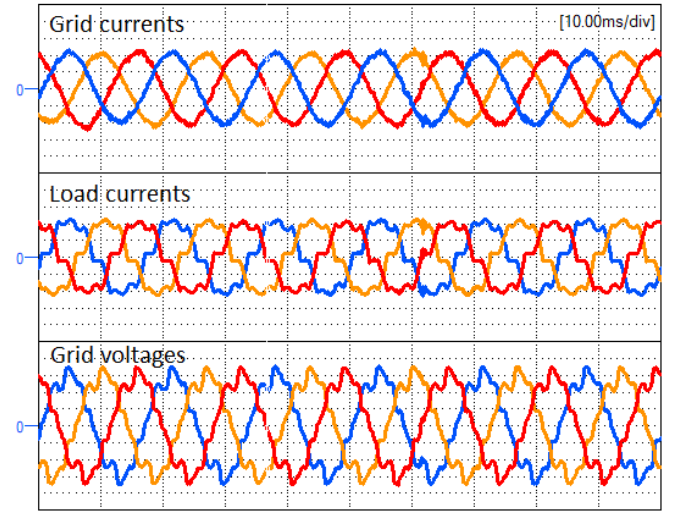
Figure 8. Grid voltages (50 V/div) with THD = 14%, and load currents and grid currents (5